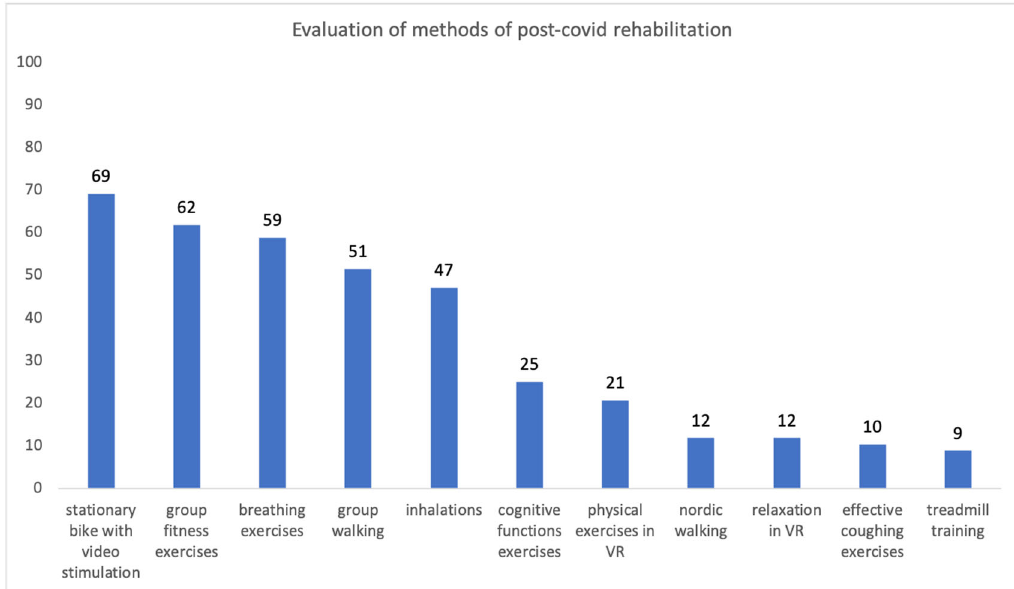
Figure 2. Evaluation of methods of post ‐ COVID rehabilitation.